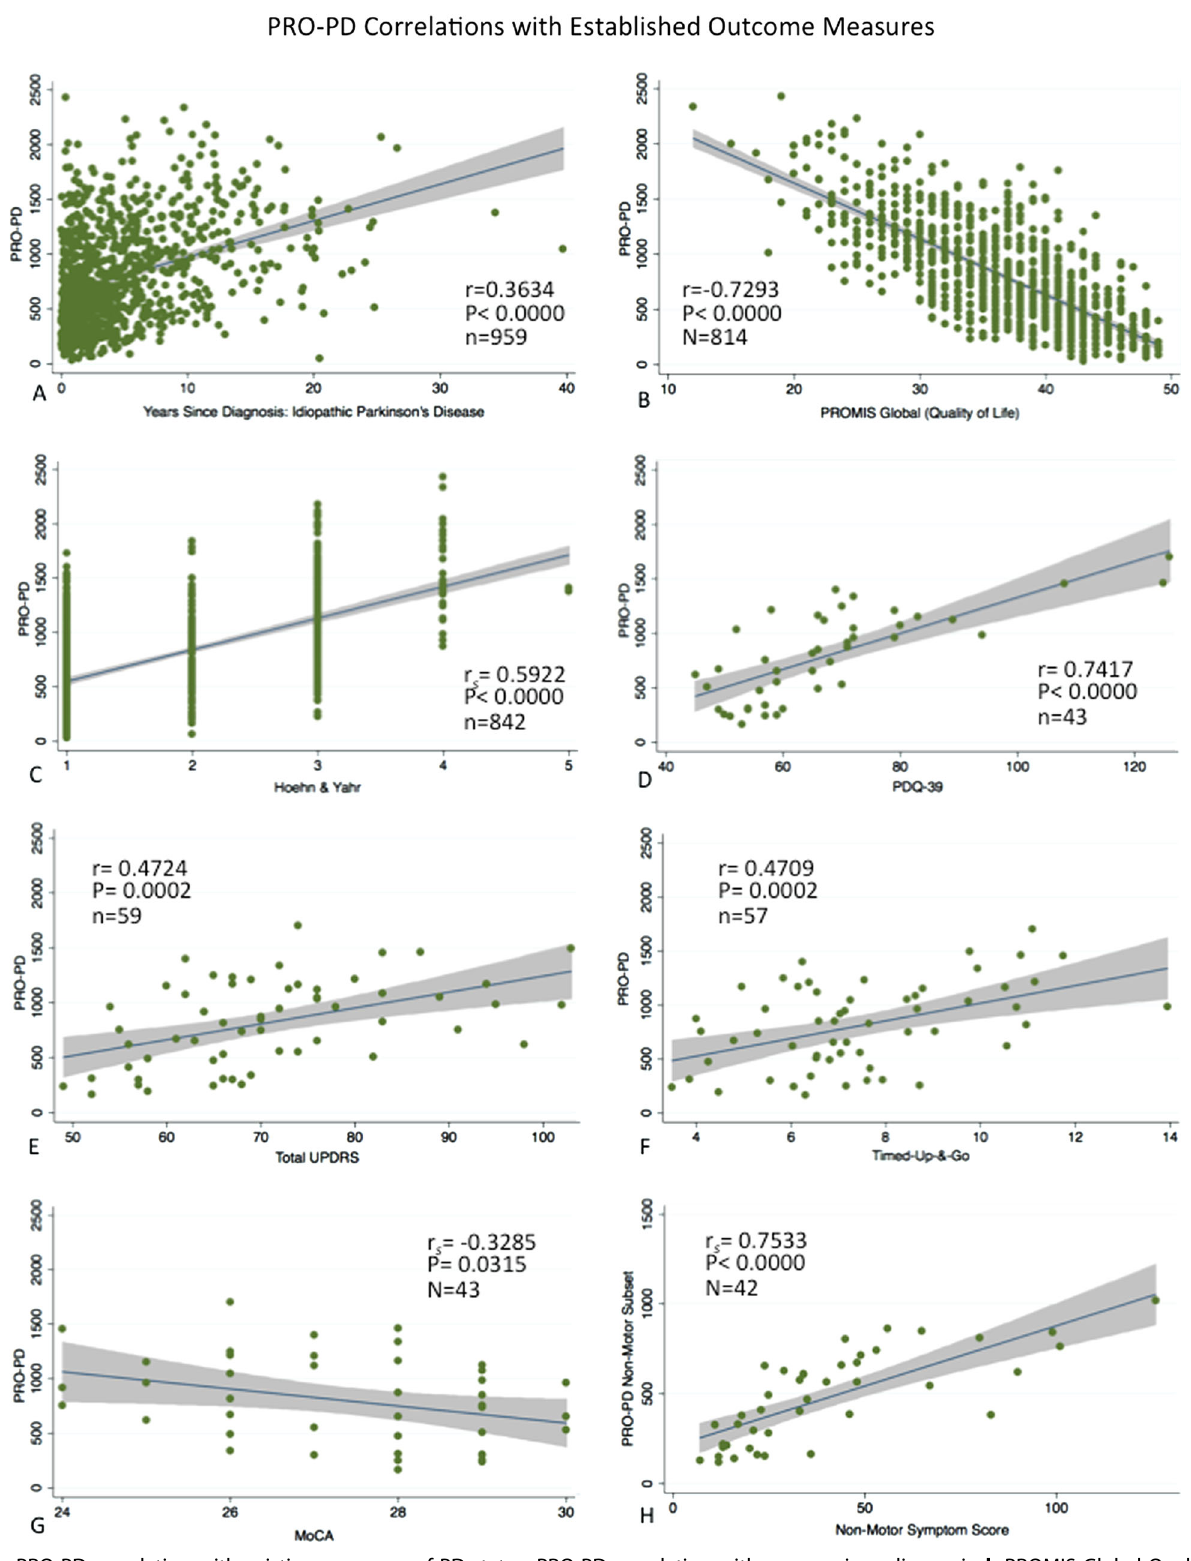
Fig. 2 PRO-PD correlation with existing measures of PD status: PRO-PD correlation with a years since diagnosis, b PROMIS Global Quality of Life, c Patient reported Hoehn and Yahr (HY), d PDQ-39, e Uni fi ed Parkinson ’ s Disease Rating Scale (UPDRS), f Montreal Cognitive Assessment, g Timed-Up & Go (TUG), and h Non-Motor Symptom Scale